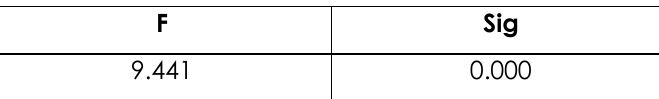
Table 10. ANOVA Table of Hypothesis